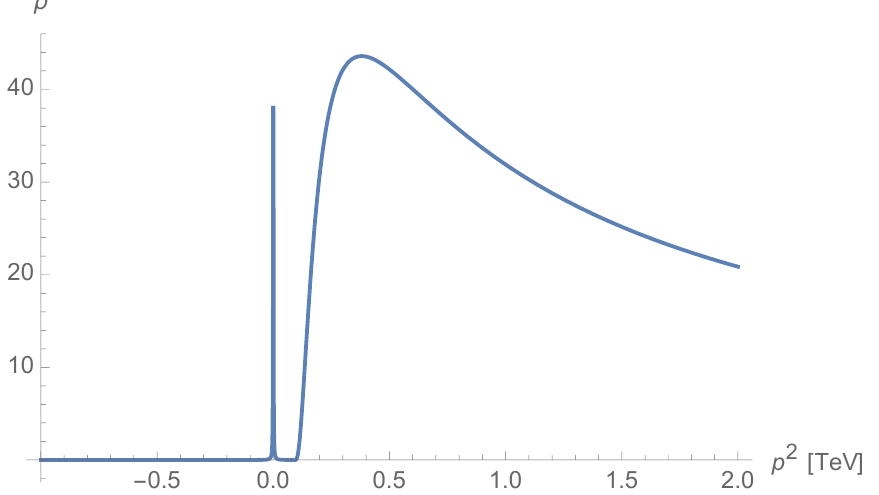
Figure 2. The V (cid:22) spectral density function, with R = 10 (cid:0) 3 , and (cid:22) = 0 : 3